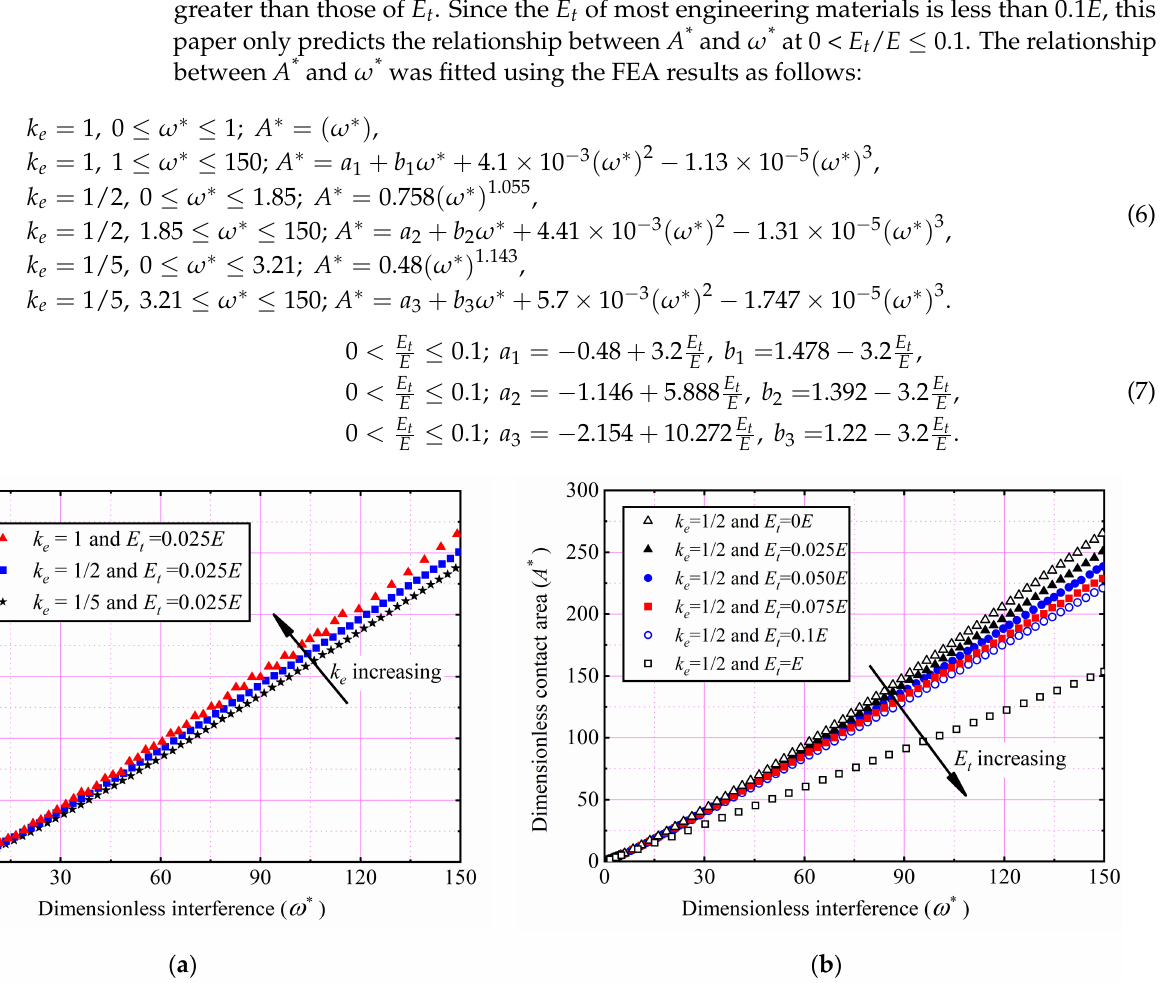
0.025, 0.05, 0.075, 0.1 and 1 at F * ≤ 1200. Figure 6a shows the relationship between A *